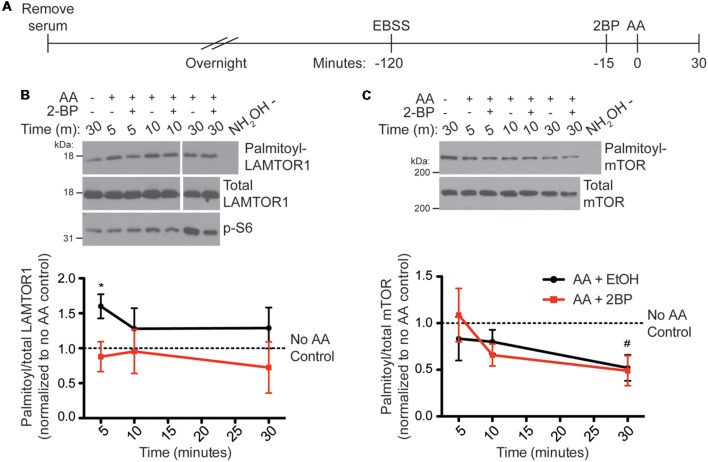
LAMTOR1 palmitoylation is rapidly increased and mTOR palmitoylation is decreased by amino acid stimulation (of mTORC1) in HEK293T cells. (A) Scheme of the AA stimulation paradigm. HEK293T cells were incubated in serum-free media 16–20 h (overnight) prior to being placed in EBSS. One hour and 45 min later cells were treated with ethanol (EtOH) or 20 μM 2BP to inhibit palmitoylation. Cells were stimulated 15 min later with 2× MEM amino acids (AA) and harvested at 5, 10, and 30 min post-stimulation. Control cells were lysed 30 min after sham stimulation with buffer alone. Palmitoyl-proteins were isolated by ABE and samples were blotted for LAMTOR1 (B) and mTOR (C) in the ABE fraction (top) and total lysate input fraction (middle). Lysates were also blotted for pS6 (bottom panels). Panels are composites of the same Western blot image. Lower histograms show quantified data from N = 4 experiments [*Student’s t-test with Welch’s correction vs. unstimulated condition (no AA control, first lane of western blot) for LAMTOR1, p = 0.040; #Student’s t-test with Welch’s correction vs. unstimulated condition (no AA control, first lane of western blot) for mTOR, p = 0.041].